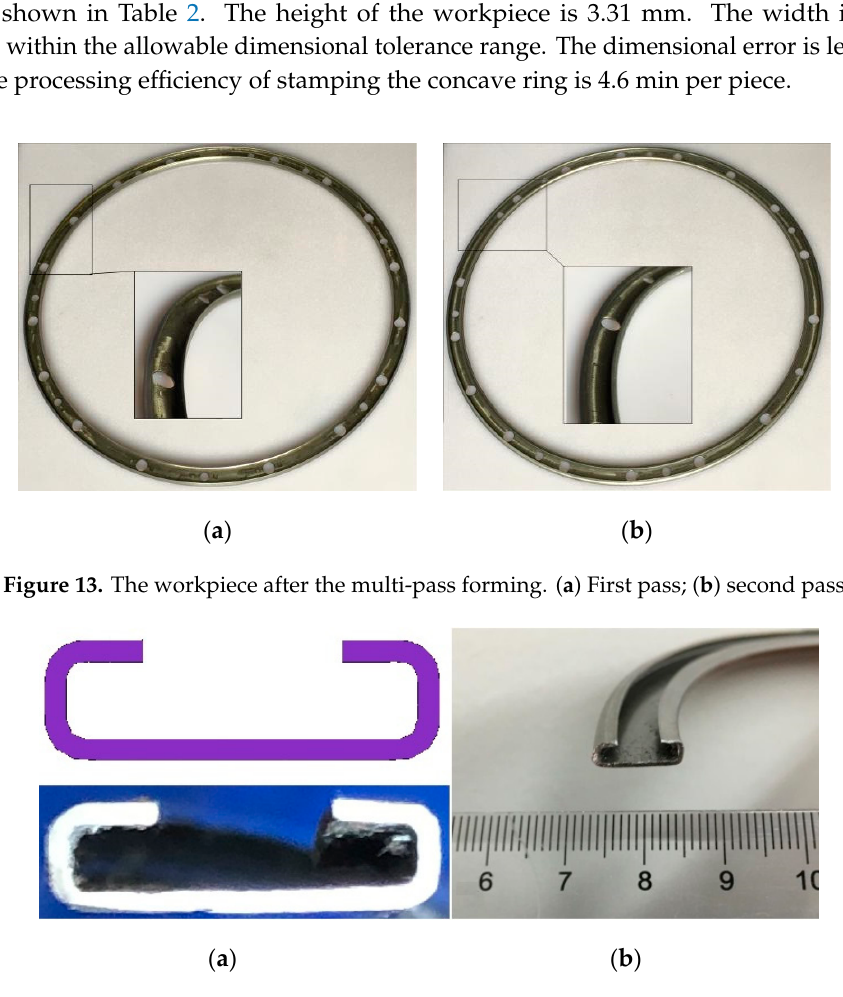
Figure 14. Results of the second pass. ( a ) Comparison of the cross-section of the experimental and the simulated workpiece; ( b ) dimensional measurement of the experimental workpiece. Table 2. Dimensional measurement results of the experimental workpiece.